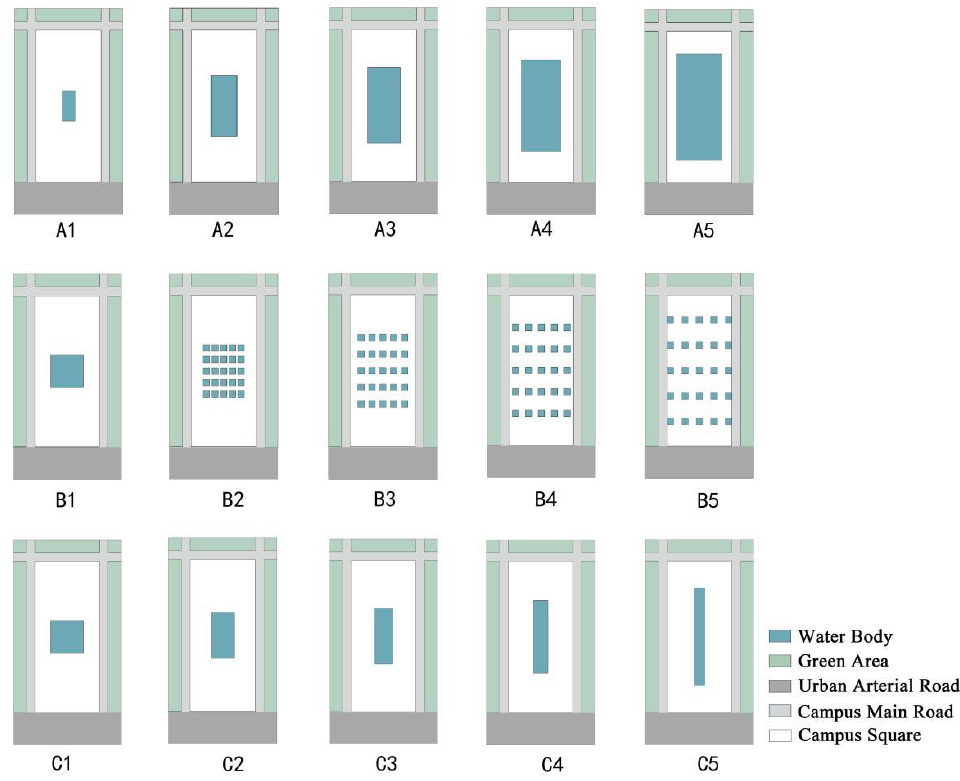
Figure 5. Illustration of 15 campus square water layout models. ( A1 – A5 ), different water body scale models. ( B1 – B5 ), different water body dispersion models. ( C1 – C5 ), different water body shape models. Table 2. Detailed dimensions of the campus square water layout model.